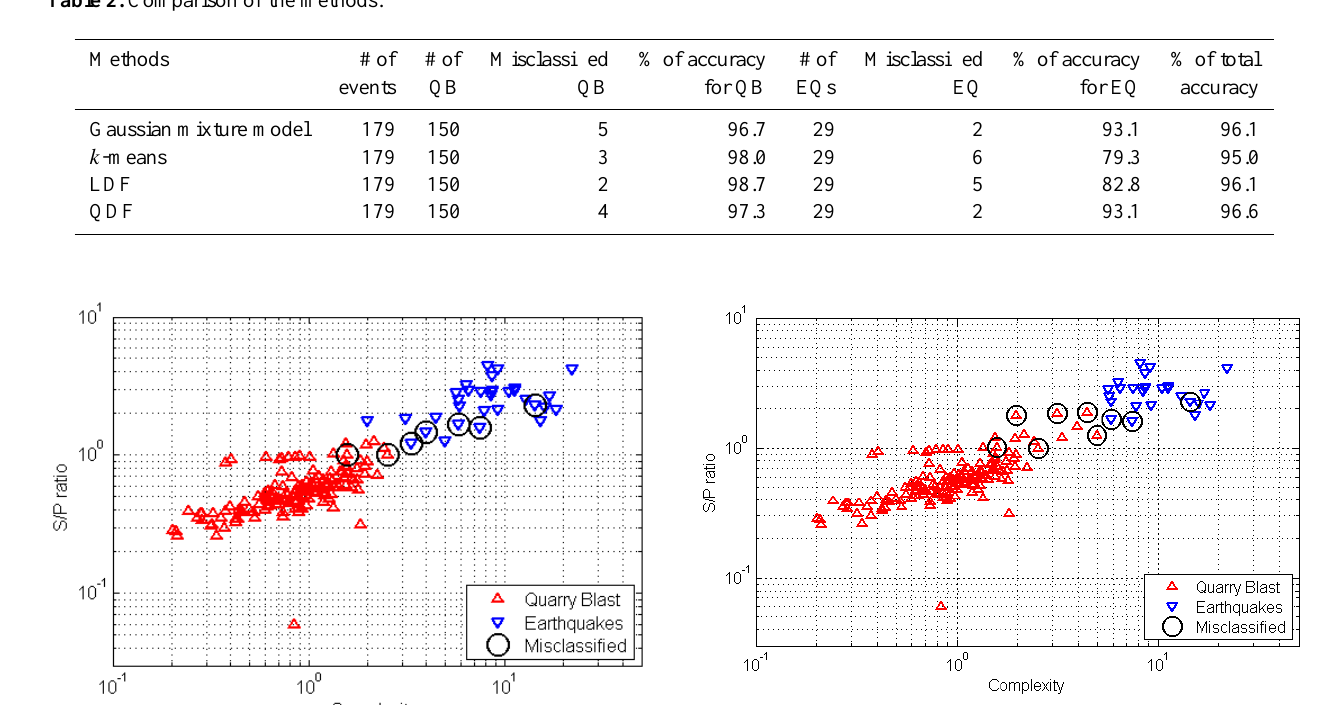
Table 2. Comparison of the methods.